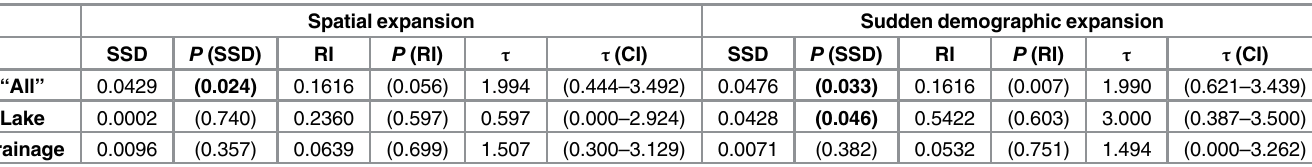
Table 3. Results of mismatch distribution analyses for Lake Donggi Cona Radix specimens based on mtDNA. SSD = sum of squared deviations from the respective model; RI = raggedness index; τ = population parameter tau with 95% confidence interval; P = significance of the respective parameter (level 0.05).